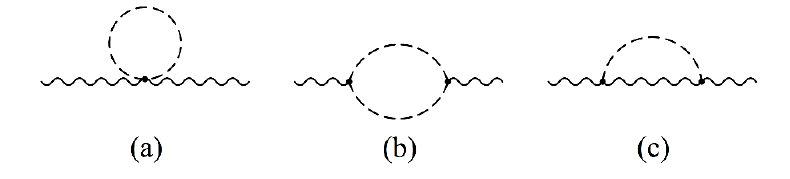
Figure 1 . Feynman diagrams relevant for the contributions of the scalar sector to the oblique